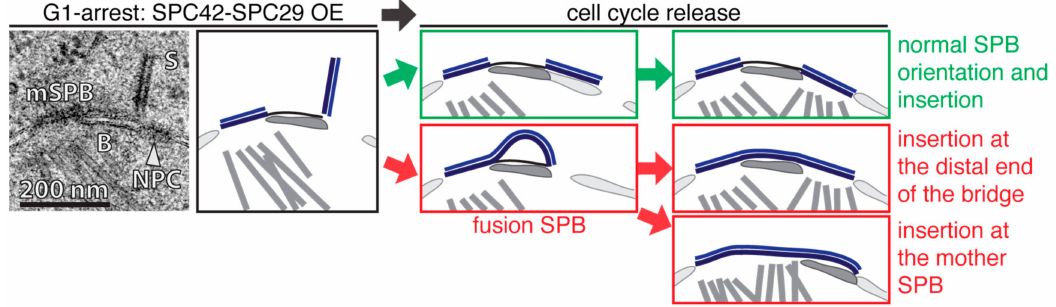
Figure 2. Over-expression (OE) of SPC42 and SPC29 in G1 arrested cells. In the top left an EM micrograph and a corresponding comic show a mother SPB (mSPB) of an α -factor arrested cell with an extended satellite (S) after SPC42 and SPC29 OE. Both structures are connected via the bridge (B) and a nuclear pore complex (NPC) is localizing adjacent to the S. On the top right ( green ) a normal dSPB orientation and NE insertion after release of the cell cycle block is indicated. In the bottom right ( red ) the formation of a fusion SPB is after the release back into the cell cycle is illustrated. This opens two possibilities for the insertion process. Either the fusion SPB inserts at the distal end of the bridge or proximal via the mSPB opening. For corresponding EM images refer to